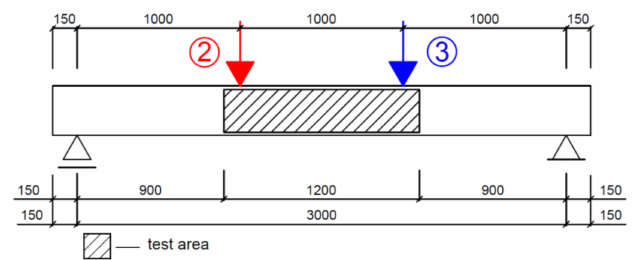
Figure 13. Loading scheme with marked test area.